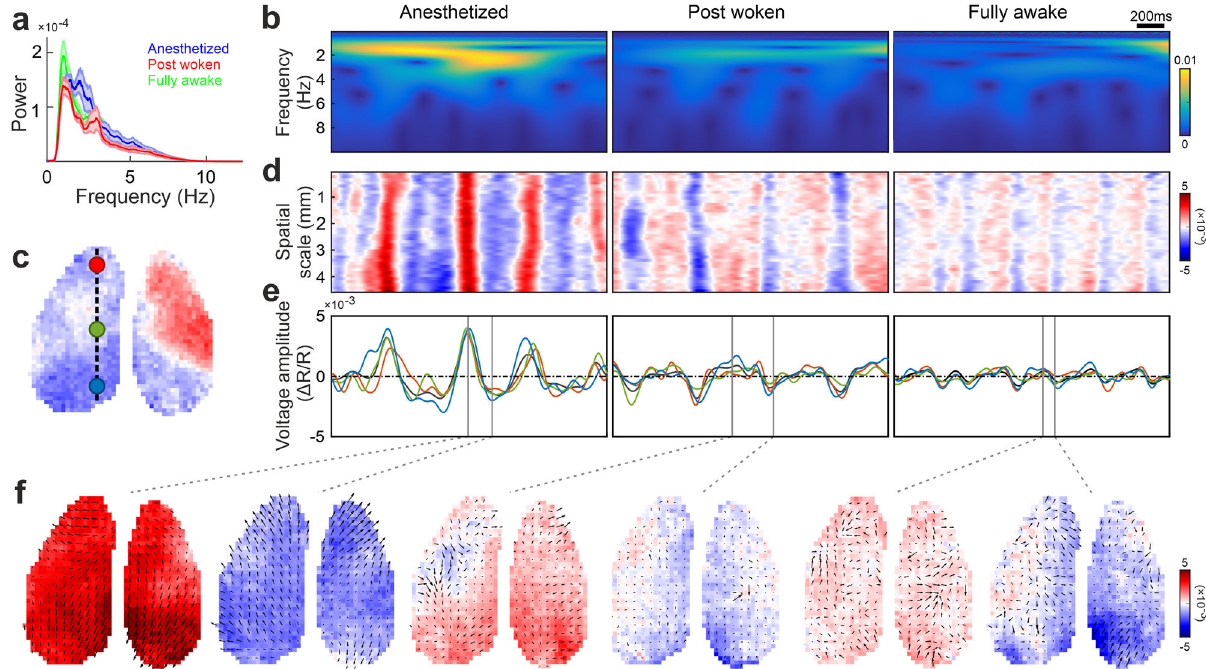
Fig. 1 | Wakefulness alters cortical voltage activity patterns. a Power spectrum of the average cortex-wide voltage activity at different brain states (mean+SEM. SEMisindicatedbytheshading.N:anesthetized=5trials,postwoken=5trials,fully awake sample number = 19 trials). b Time-resolved power spectrum of voltage signalsatdifferentbrainstates.Voltagedatatakenfromthepositionmarkedbythe bluespotin c .Warmercolorrepresentshigherpower. c Locationofthreearbitrary spotsonthecortexmask.Thebackgroundrepresentsthevoltageamplitudeatone random time point; colorbar same as d . d Example voltage activity along an